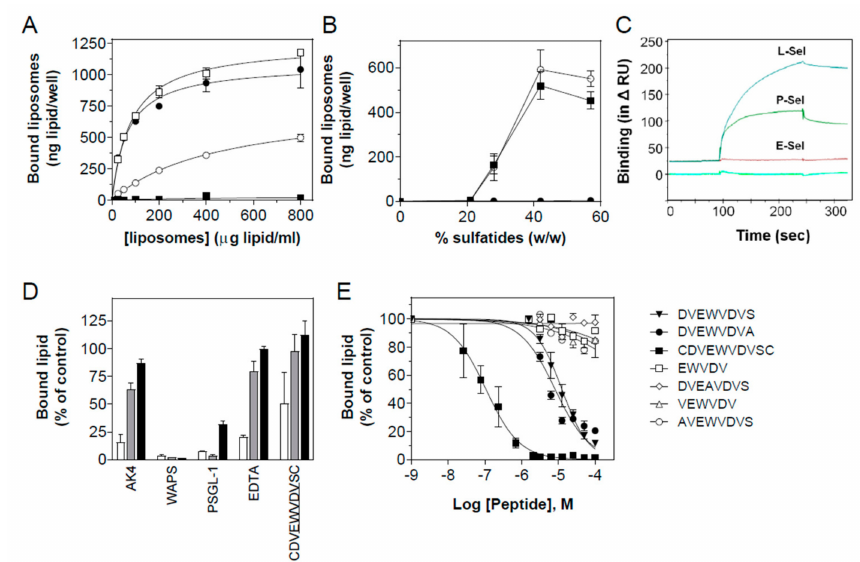
Figure 3. Characterization of sulfatide-P-selectin interaction. ( A ) Binding of sulfatide liposomes to P-selectin-coated wells. [ 3 H]-cholesteryl oleate-labeled liposomes were prepared, containing 21 (Sf21; (cid:4) ), 28 (Sf28; ), 42 (Sf42; (cid:3) ), and 57 (Sf57; (cid:8) ) % ( w / w ) sulfatides, and were tested for binding to (cid:35) P-selectin-coated wells. ( B ) Binding of sulfatide liposomes to P-, L-, and E-selectin. Sf0, Sf21, Sf28, Sf42, and Sf57 liposomes (~100 µ g / mL) were incubated in P-selectin ( (cid:4) ), L-selectin ( ), or E-selectin ( (cid:8) )-coated (cid:35) microtiter wells. No binding was detected in the control wells. Total bound lipid was calculated from recovered [ 3 H]-cholesteryl oleate and its specific activity defined in “Materials and Methods”. Data are means ± S.E.M, n = 3. ( C ) Sulfatide-coated sensor chips bind L- and P-selectin but not E-selectin. Sulfatides were immobilized on an L1 sensor chip at 5 µ L / min, and binding kinetics were measured for human Fc fusion proteins of L-selectin (blue), P-selectin (green), E-selectin (red) (all 40 nM). CD154 or CD40 were taken along as negative control but showed no detectable binding. All curves were corrected for nonspecific binding by an online baseline subtraction of ligand binding to a control flow channel. Binding kinetics were analyzed using BIAevaluation software (V2.1; Pharmacia Biosensor, Uppsala, Sweden). ( D ) Interference with sulfatide liposome binding to P-selectin. Binding of Sf28 (white bars), Sf42 (grey bars), and Sf57 (black bars) liposomes (100 µ g / mL) to P-selectin-coated microtiter wells was measured in the presence of P-selectin blocking antibodies AK-4 and WAPS12.2 (both 10 µ g / mL), rPSGL-1-Ig (15 µ g / mL), EDTA (10 mM), or CDVEWVDVSC (0.5 µ M). Data are means ± S.E.M, n = 3. ( E ) Competition studies of sulfatide liposome binding to P-selectin. [ 3 H]-cholesterol oleate-labeled Sf28 liposomes (1 x 10 5 dpm) were incubated in P-selectin-coated wells in the absence or presence of increasing amounts of peptides EWVDV ( (cid:3) ); VEWVDV ( ∆ ); DVEWVDVS ( (cid:72) ); A VEWVDVS ( ); (cid:35) DVE A VDVS ( ♦ ); DVEWVDV A ( (cid:8) ); CDVEWVDVSC ( (cid:4) ). Data are expressed as % of total P-selectin binding in the absence of inhibitors ( = 100%). Data are means ± S.E.M, n =